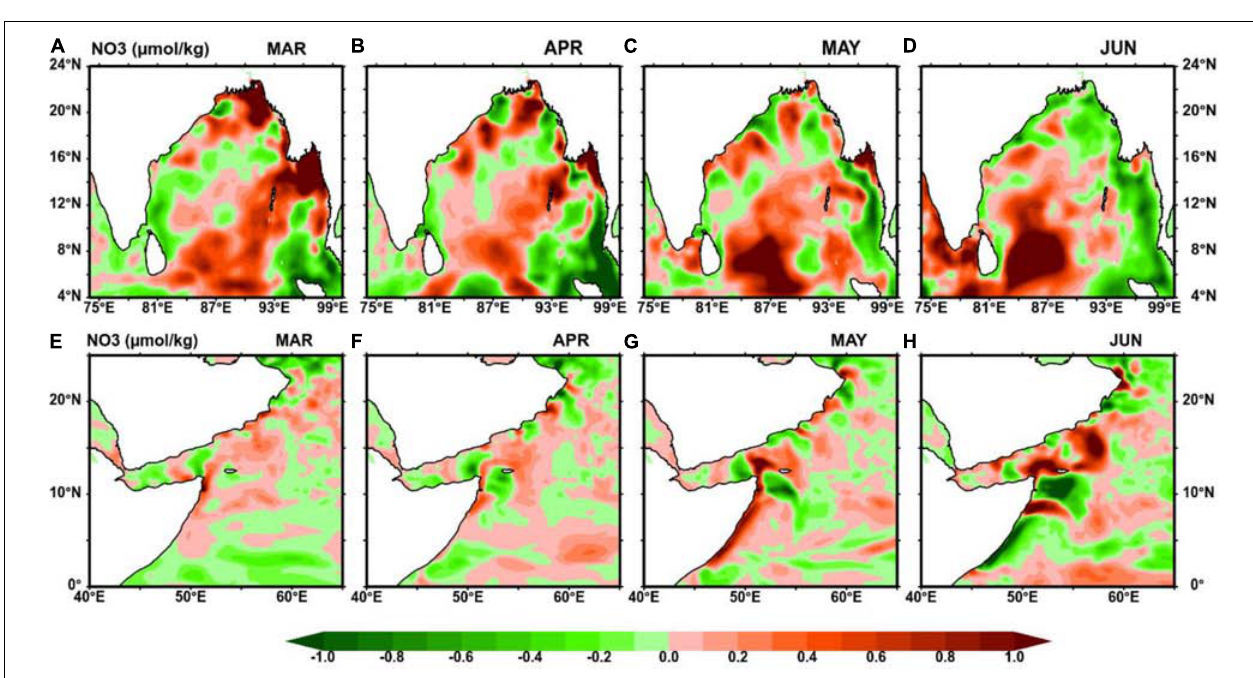
loading, the Moderate Resolution Imaging Spectro-radiometer Aqua (MODIS Aqua) derived AOD is utilized. The AOD data are from the level 3 of MOD08_D3_v6.1 with 1 ◦ spatial resolution. The combined dark target and deep blue